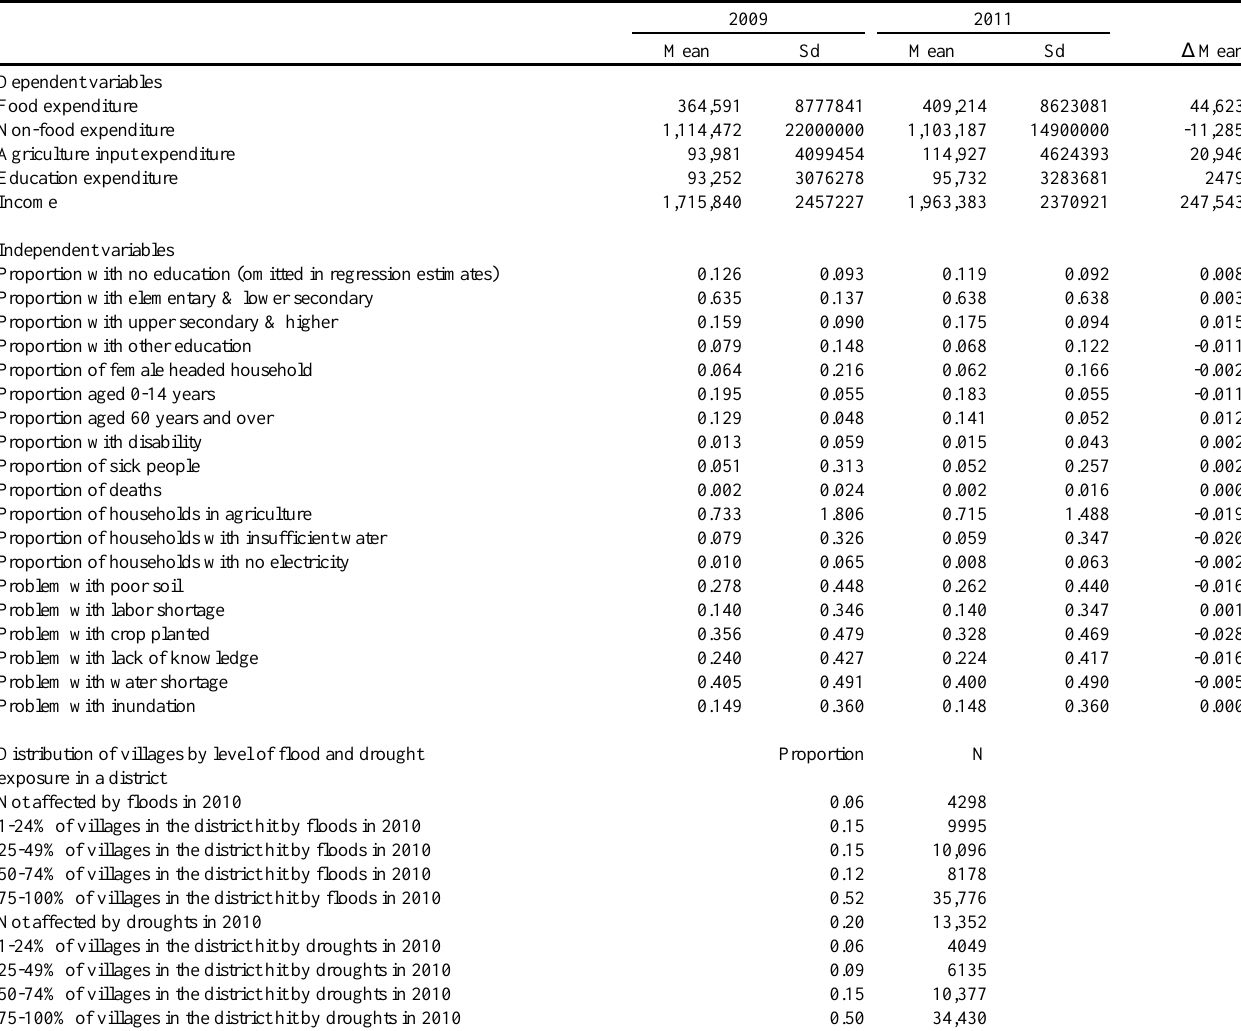
Table 1 . Summary statistics of dependent and independent variables for the years 2009 and 2011 (N =